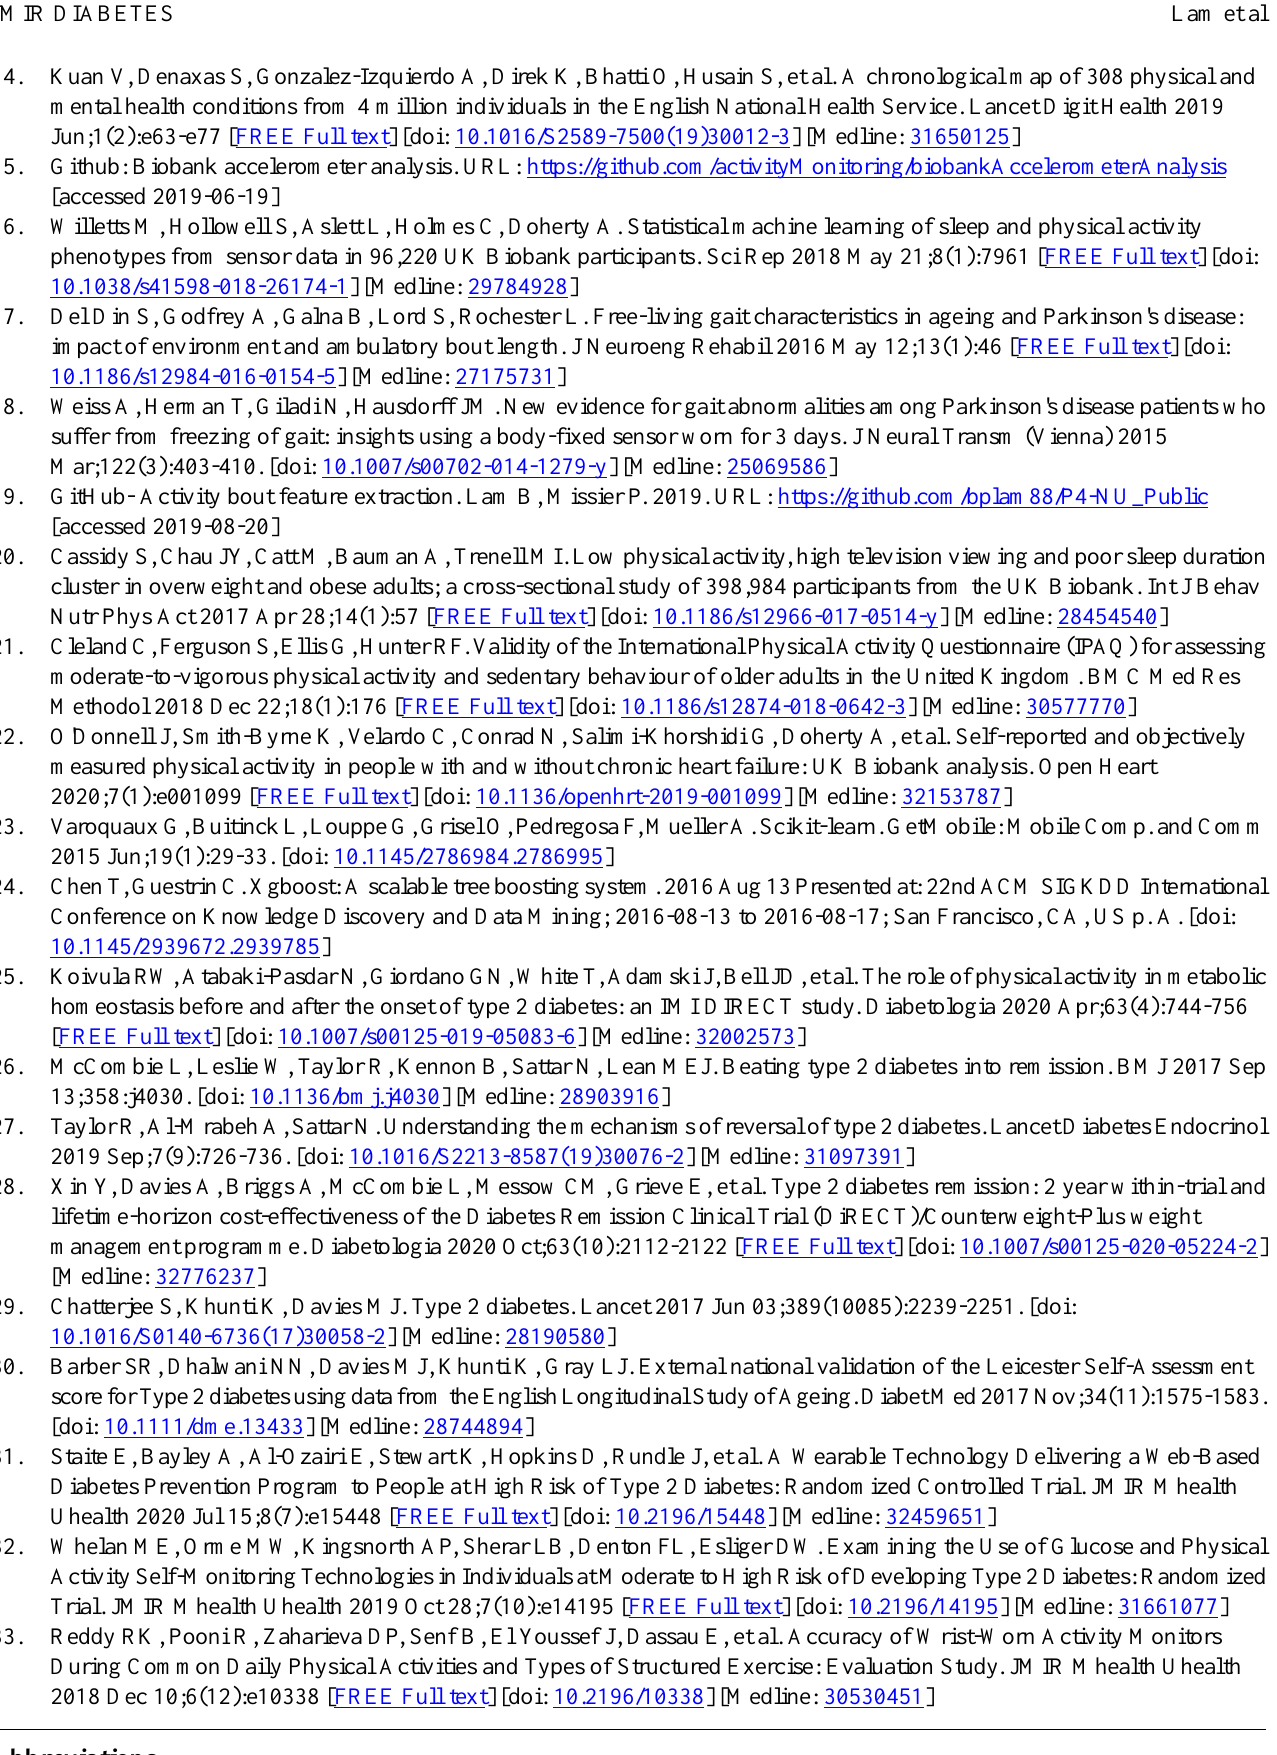
AUC: area under the receiver operating characteristic